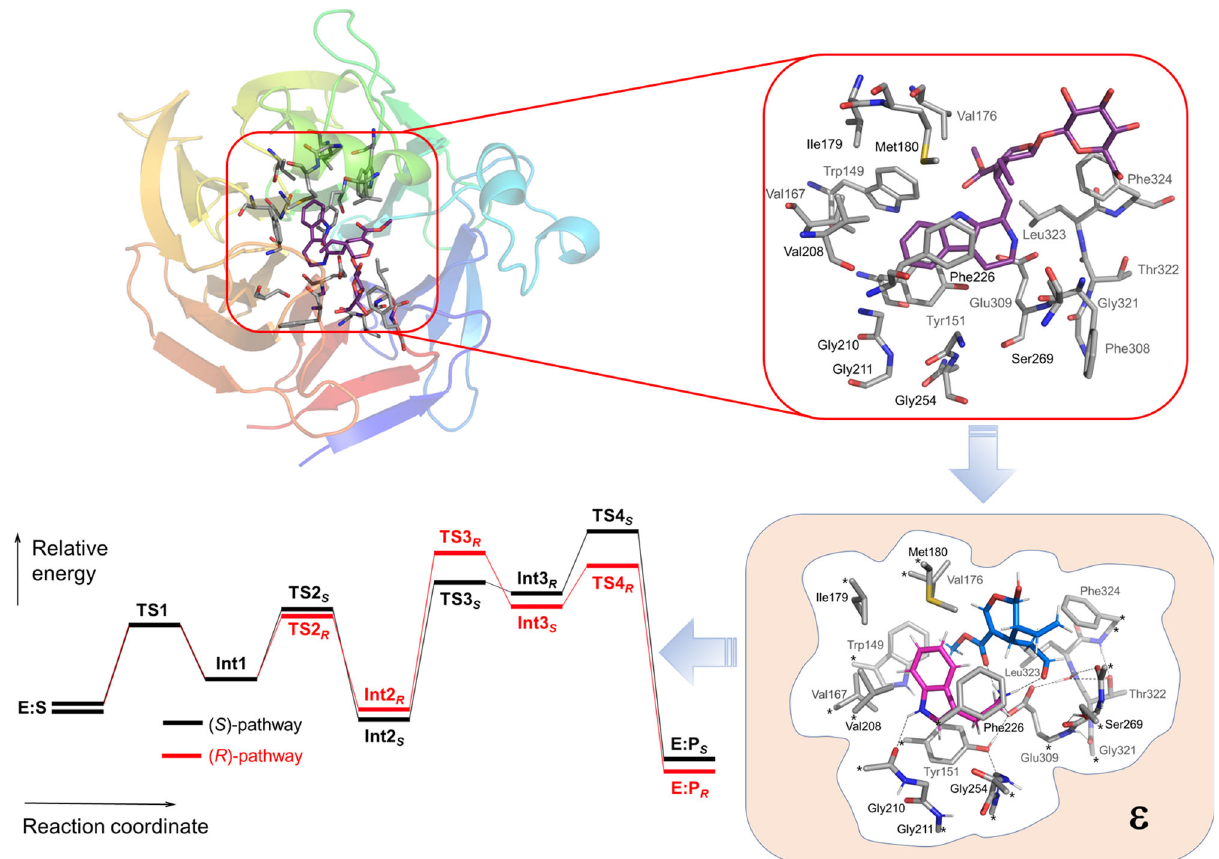
Fig. 1 Schematic drawing of the steps involved in the cluster approach. A model of the active site is designed on the basis of a crystal structure. A number of positions at the edge of the model are kept fi xed during the geometry optimizations, and the surrounding is modeled as a continuum solvent. Intermediates and transitions states are located and their energies are used to judge reaction mechanisms and elucidate the origins of selectivity.